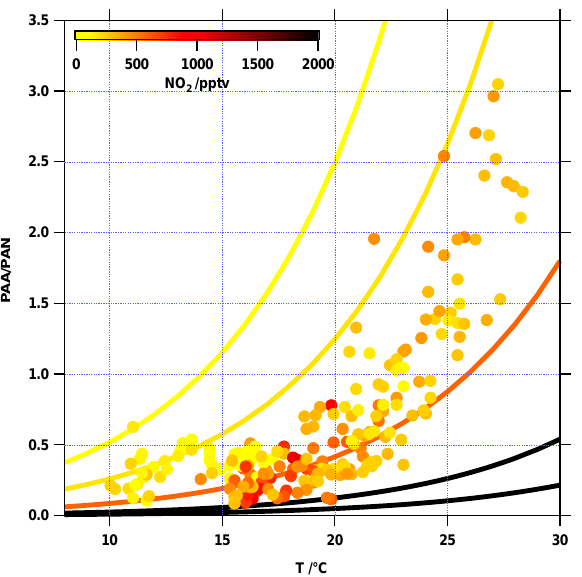
Fig. 7. The relationship between the HUMPPA-COPEC PAA/PAN ratio and temperature. The solid lines are calculations of the ratio based on expression (2) at mixing ratios of NO 2 corresponding to 0.1, 0.2, 0.6, 2, and